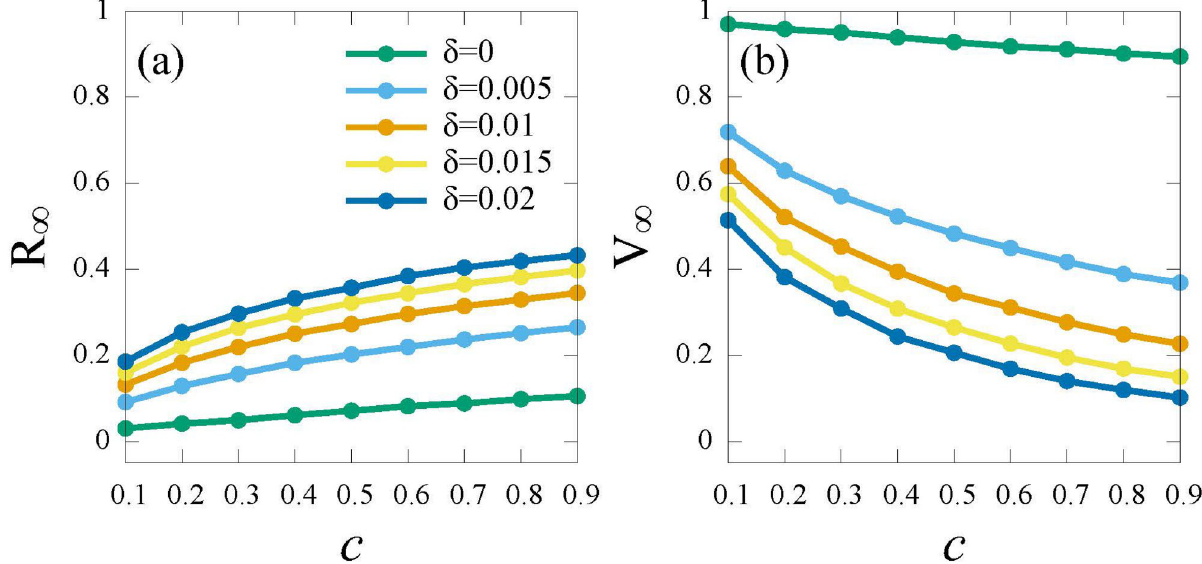
Fig 10. The epidemic scale R 1 and the vaccinate coverage V 1 versus cost ( c ) for different time-sensitivity of vaccine ( δ ) under the RPS strategy. (a) R 1 ; (b) V 1 . Here, the infection rate λ =